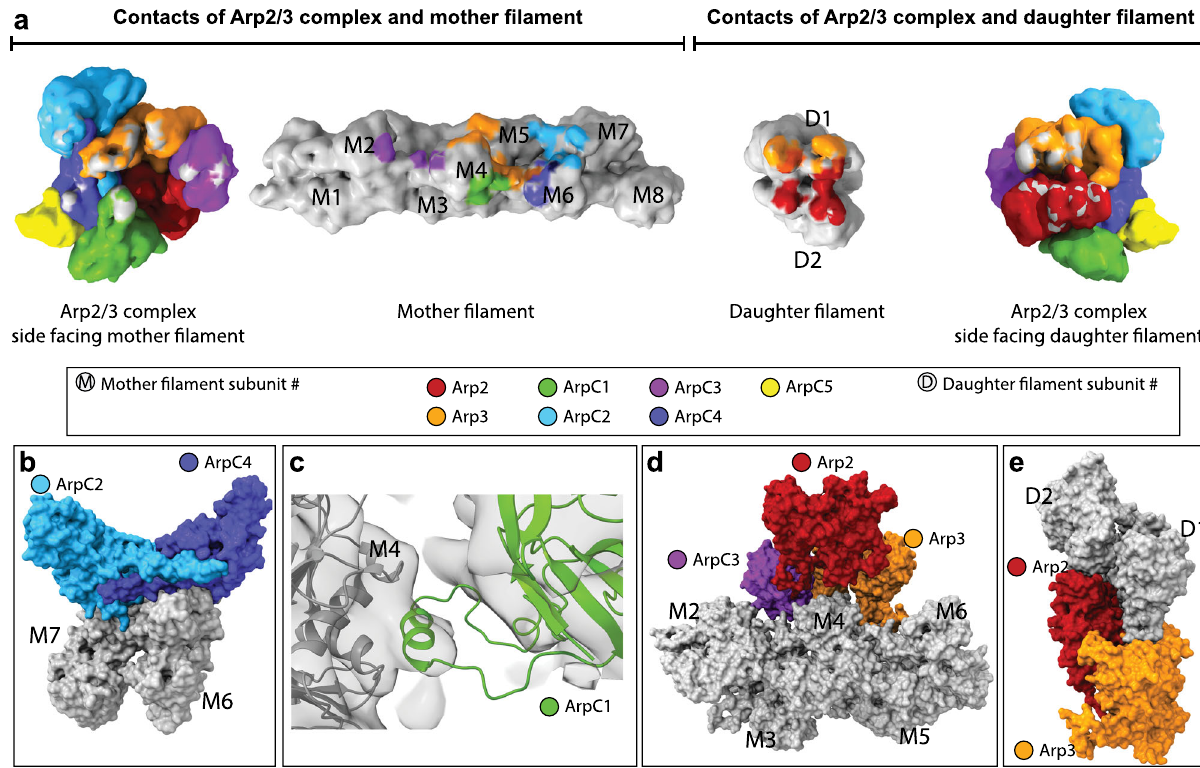
Fig. 3 Actin – Arp2/3 complex interaction surfaces within the branch junction. a Interaction surfaces between the Arp2/3 complex, and the actin mother and daughter fi lament. The surfaces for the Arp2/3 complex, mother and daughter fi lament are shown as density maps at 9.5 Å resolution generated from their respective models. Gray coloring on the surface of Arp2/3 subunits indicates contact sites with actin and coloring of actin subunits in a speci fi c color indicates a contact site with the associated Arp2/3 subunit. Subunit colors are annotated in the fi gure with Arp2 being red, Arp3 orange, ArpC1 green, ArpC2 light blue, ArpC3 violet, ArpC4 dark blue, and ArpC5 yellow. Actin is shown in gray. The numbering of the mother (M#) and daughter (D#) fi lament subunits is also indicated. Coloring was applied via the color zone command in ChimeraX in a 5.5 Å radius around each C-alpha atom of the underlying model, which was positioned in a 10 Å radius to a C-alpha atom of its putative interactor. b Surface representation of the interaction of ArpC2 and ArpC4 with the mother fi lament subunits M6 and M7 (the interaction of ArpC2 with M5 is omitted for clarity). c The protrusion helix of ArpC1 fi tted into its density close to subdomains 1 and 3 of M4. d Surface representation of the interactions of Arp3 and ArpC3 with the mother fi lament. Note the cavity below Arp2, where no contacts between the Arp2 subunit and the mother fi lament are observed. ArpC3 acts as a linker between Arp2 and the mother fi lament. e Surface representation of the interaction between Arp2, Arp3, and the fi rst two subunits of the daughter fi